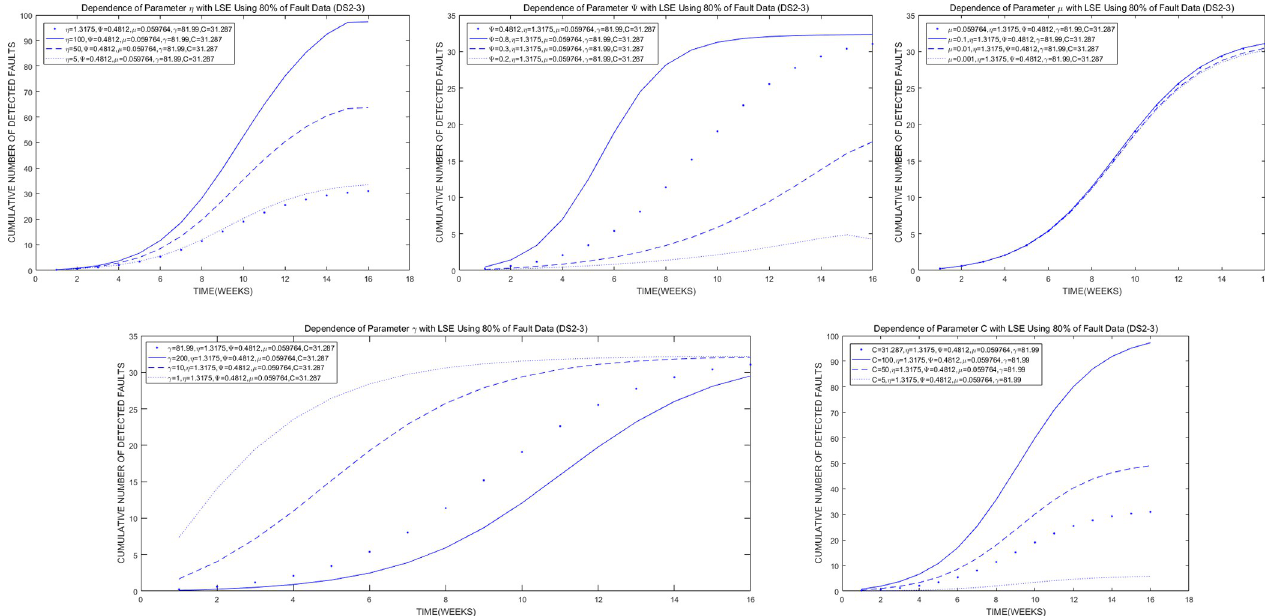
Fig 4. Sensitivity analysis for the parameters of the proposed model. (a) Changes in parameter η of the proposed model with LSE using 80% of DS2-3. (b) Changes in parameter ψ of the proposed model with LSE using 80% of DS2-3. (c) Changes in parameter μ of the proposed model with LSE using 80% of DS2-3. (d) Changes in parameter γ of the proposed model with LSE using 80% of DS2-3. (e) Changes in parameter C of the proposed model with LSE using 80% of